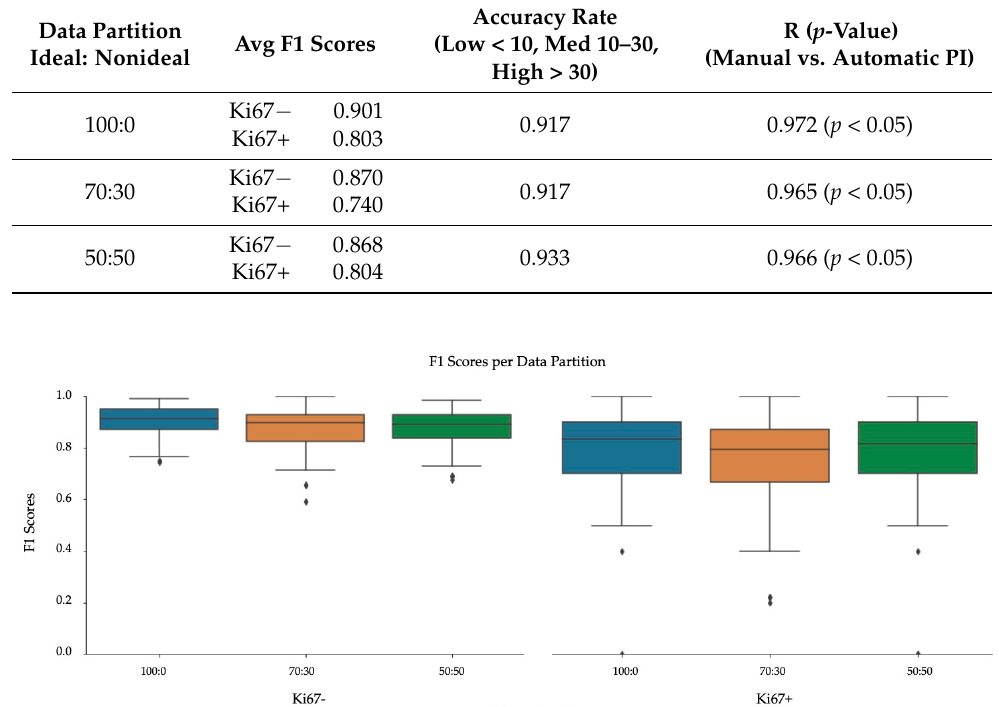
Table 5. Average F1 scores and accuracy rate across three data partitions.